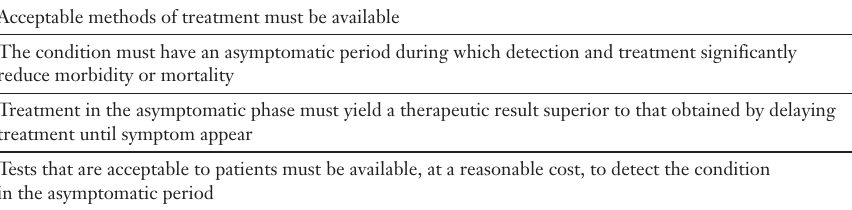
The condition must have a significant effect on the quality and quantity of Required prerequi- sites for screening [3].